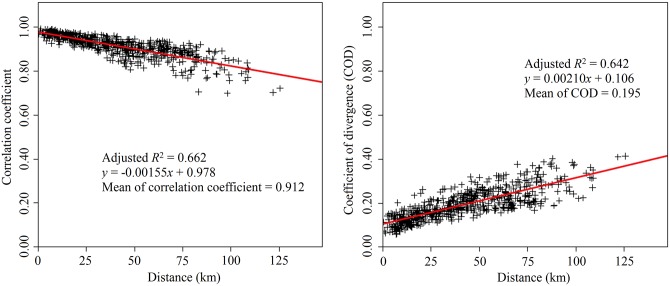
Correlation coefficient and COD versus distance between the stations.